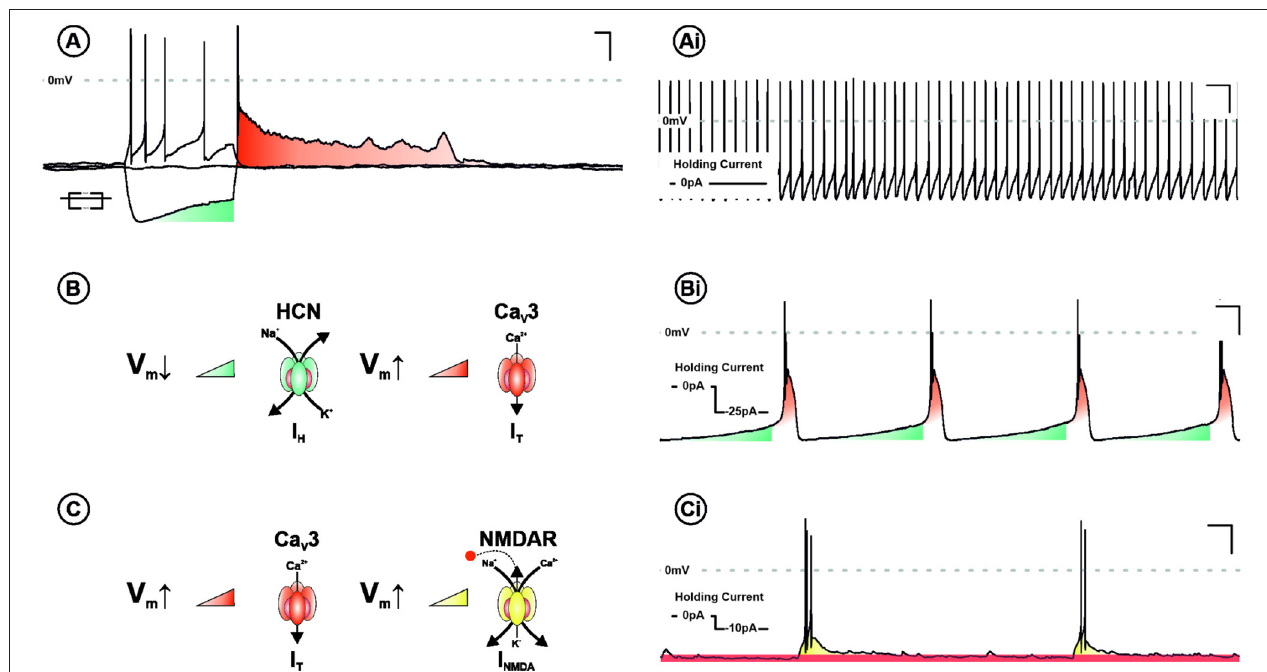
FIGURE 2 | Ionic mechanisms underpinning burst firing in the LHb. (A) Voltage response of a LHb neurone to negative and positive square form current injection. Note the depolarising sag (blue) and subsequent rebound excitation (red). In addition to tonic discharge patterns (Ai) , LHb neurones are capable of two mechanistically distinct modes of burst firing. Both require membrane hyperpolarisation and are characterised by rhythmic periods of depolarisation, capped by high frequency action potentials. One mechanism, requiring more pronounced depolarisation, is cell autonomous and recurrent (B) . This cycle relies on the sequential activation and de-inactivation of hyperpolarisation-activated cyclic nucleotide–gated channels (HCN—blue) and T-type calcium channels (Ca V 3—red), respectively (Bi) . The other is network dependent (C) and occurs within a specific membrane potential range ( − 55 to − 65mv). This depends on the interplay between Ca V 3 and NMDA receptors (NMDARs—Yellow). Activation of T-type removes Mg 2 + -dependent blockade of NMDARs, synergistically driving a burst of action potentials. With membrane potential repolarisation Ca V 3 channels de-inactivate permitting the cycle to begin again (Ci)